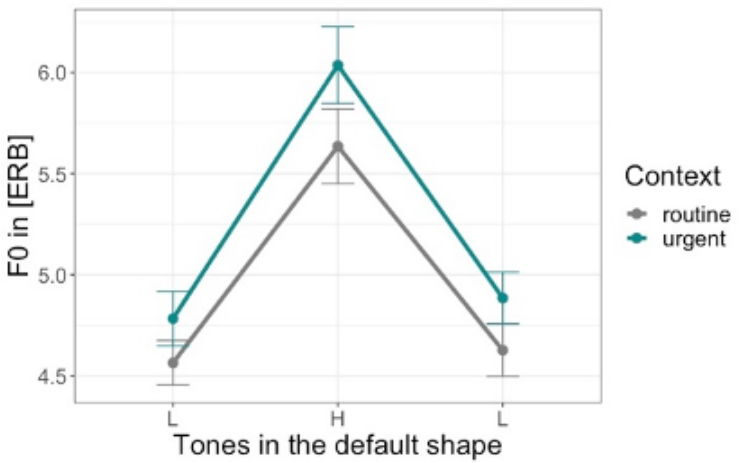
Figure 10. F0 scaling of the default contour in the routine and urgent context for three syllabic words with L H L lexical tones in